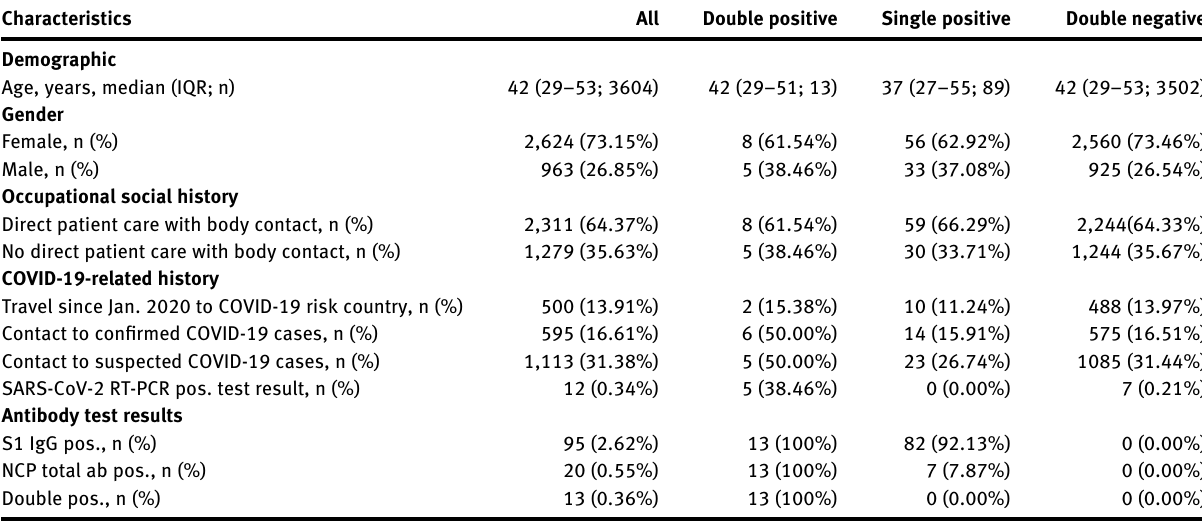
Table  : Study population.